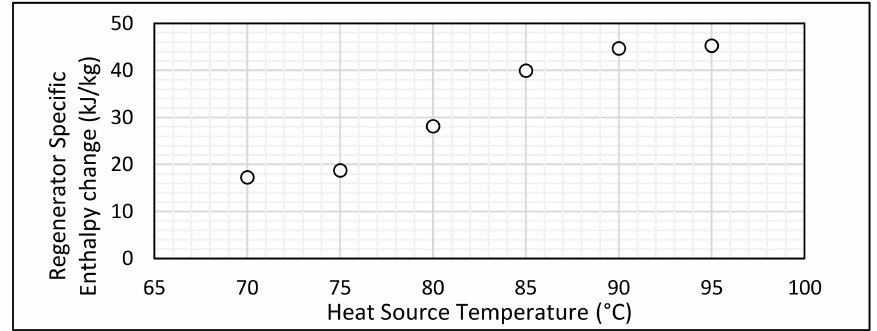
Figure 11. Variation in regenerator-specific enthalpy change as the heat source temperature changes for a pump speed of 40